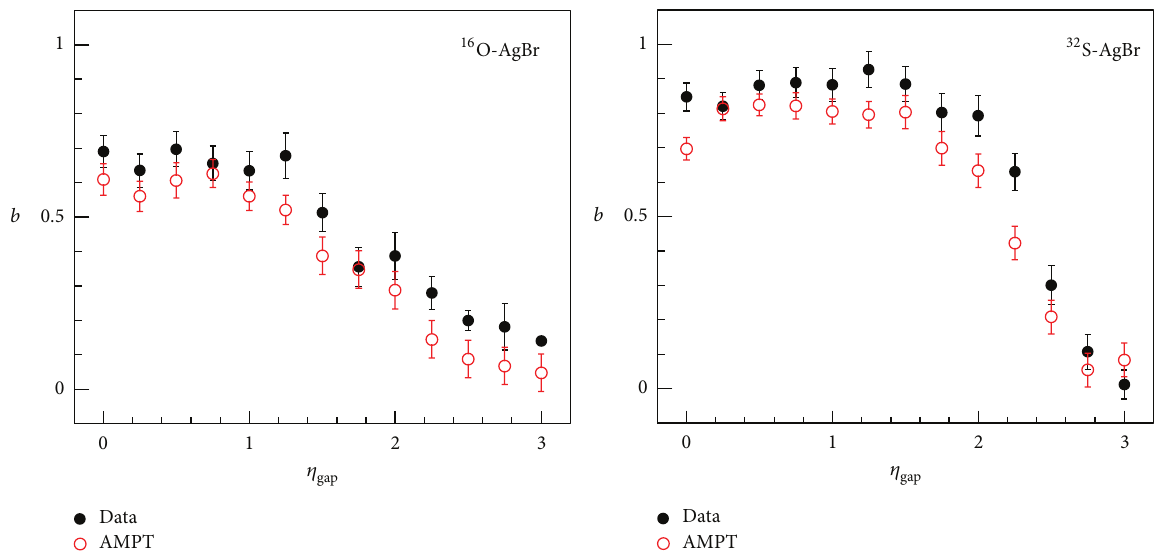
Figure 6: Dependence of correlation strength, 𝑏 on separation gap between two symmetric pseudorapidity windows, 𝜂